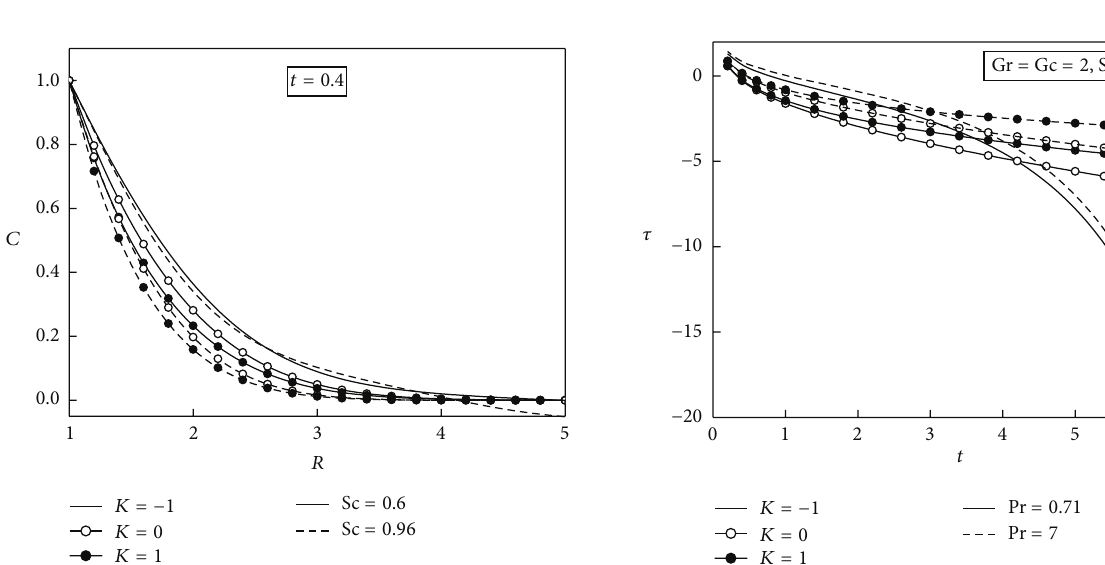
Figure 6: Temperature profiles for different values of the Prandtl number and time.